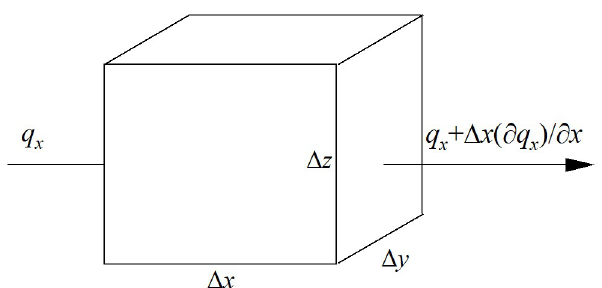
Figure 3. One-dimensional seepage of a unit body.